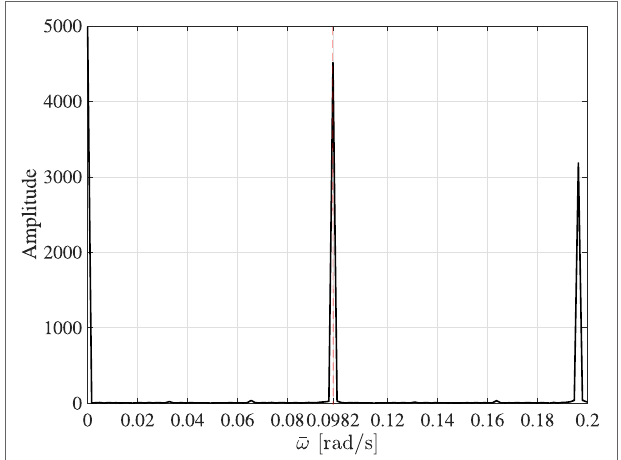
FIGURE 12 | The Fast Fourier Transform of the input pulsating load has identified a countable number of spikes at different frequencies. Two spikes in the low frequency regime are shown here.